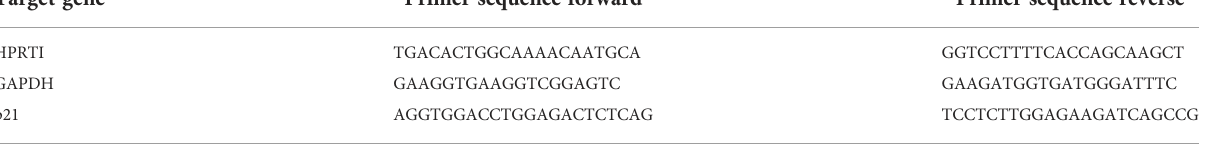
TABLE 1 Primer sequences for HPRTI (housekeeping gene for NB cell lines), GAPDH (housekeeping gene for MRC5 and HL-60) and p21, respectively. Target